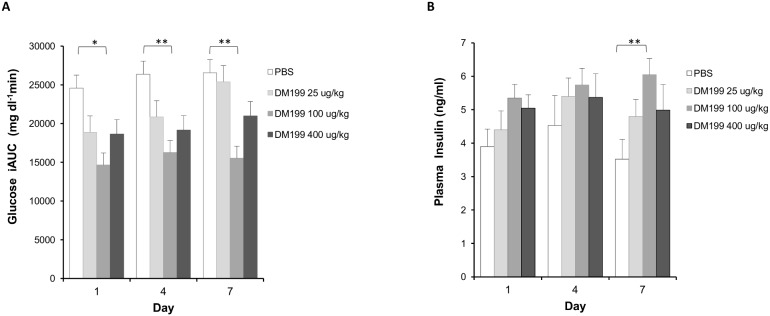
Effects of sub-acute DM199 dosing in ZDF rats.At 72-hour intervals (Day 1, 4 and 7), 11-week old male ZDF rats (n = 8) were fasted overnight (12 hrs.) and injected s.c. with either PBS (Control) or DM199 (25, 100 or 400 µg/kg). (A) After 120 min, rats were gavaged with 2 g/kg glucose solution, blood was sampled just prior to oral gavage (t = 0), and subsequently at 30 min intervals over a 120 minute period. For each dosing, glucose iAUC was calculated using t = 0 glucose value as background. (B) Average plasma insulin levels from fasted rats (t = 0). *p<0.05; **p<0.01 vs. control.